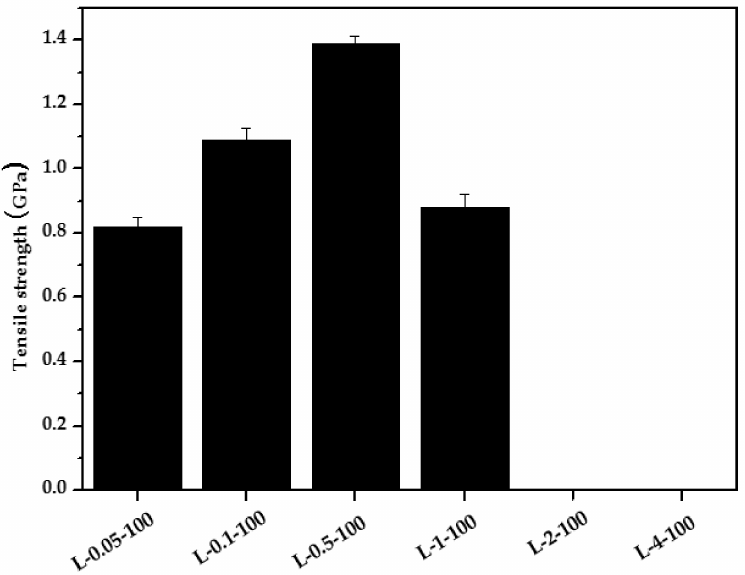
Figure 5. Tensile strength of carbon fibers obtained from lyocell fabrics grafted with PAM via EBI.